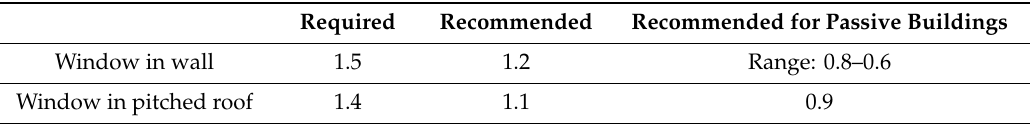
Table 2. Standard values of thermal transmittance, U w (W/(m 2 ·K)), adapted from the Czech national standard [18].